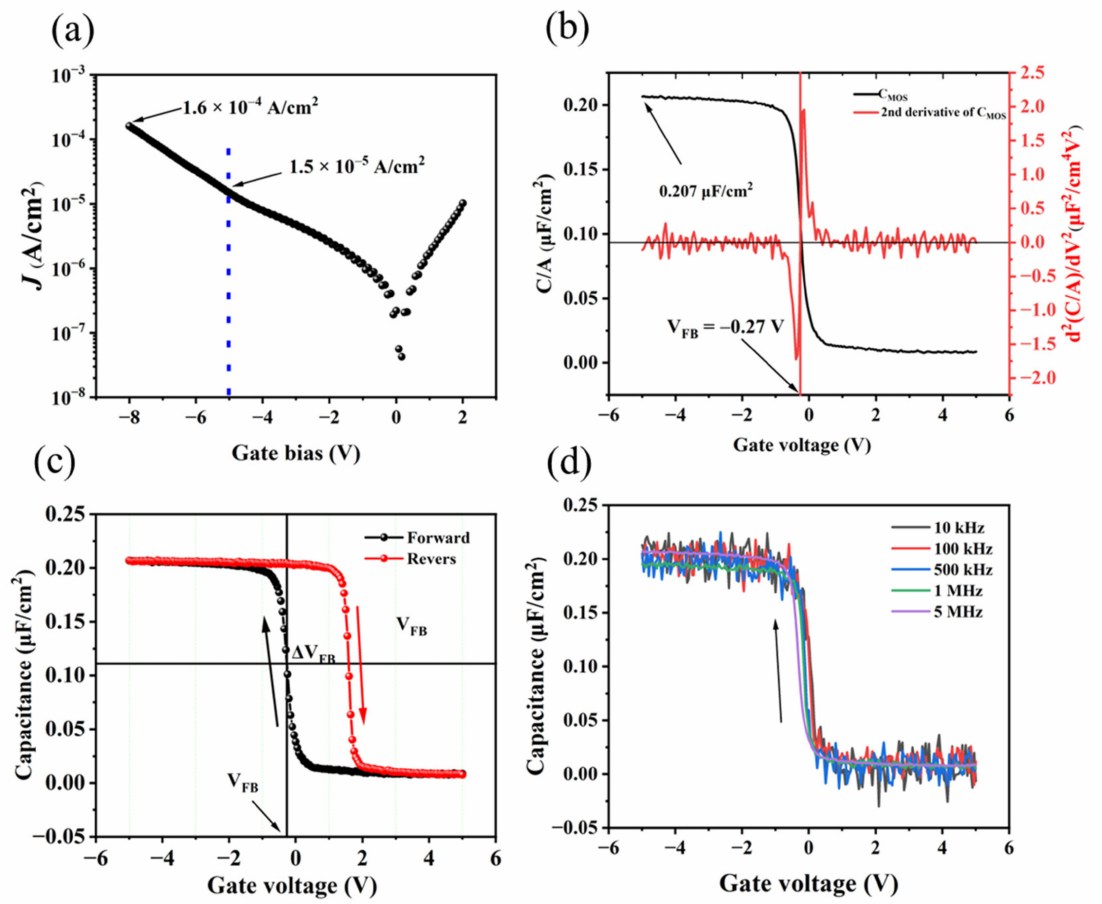
Figure 3. ( a ) J-V characteristic of SnO x /H-diamond MOS diode. ( b ) The solid line describes a capacitance voltage characteristic. The dotted line is the second derivative of capacitance as a function of gate voltage. ( c ) Capacitance voltage characteristics at 5 MHz ( d ) Capacitance voltage characteristics at different